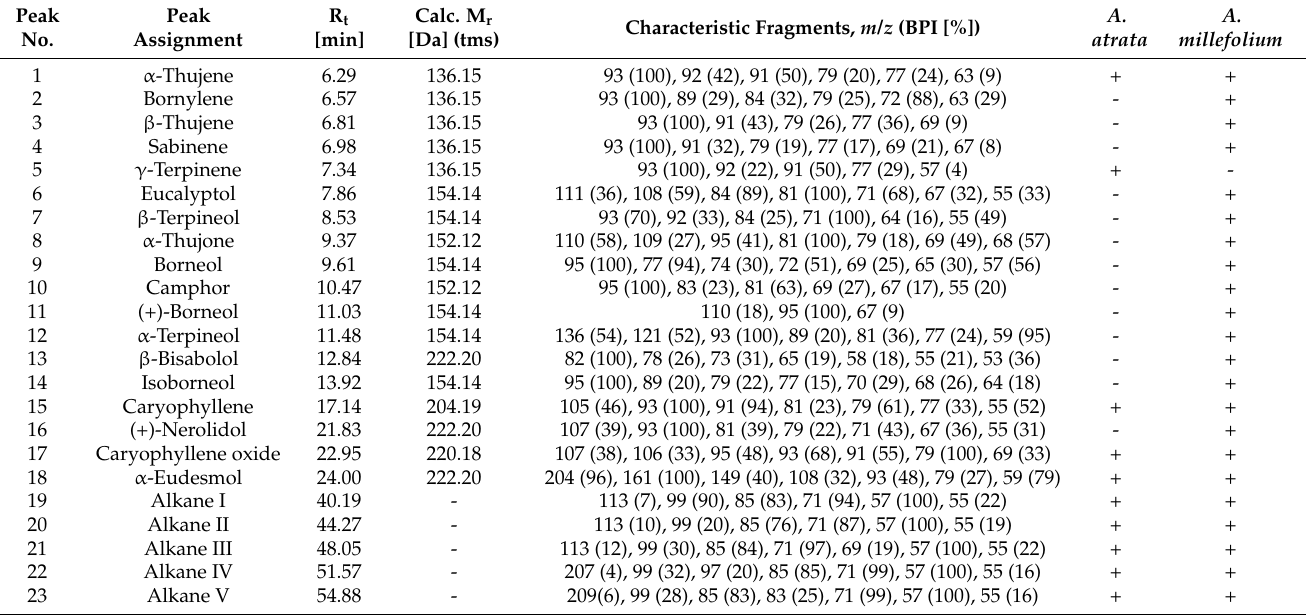
Table 2. Gas chromatography-mass spectrometry (GC-MS) analyses of A. atrata and A. millefolium dichloromethane fractions (DCM).